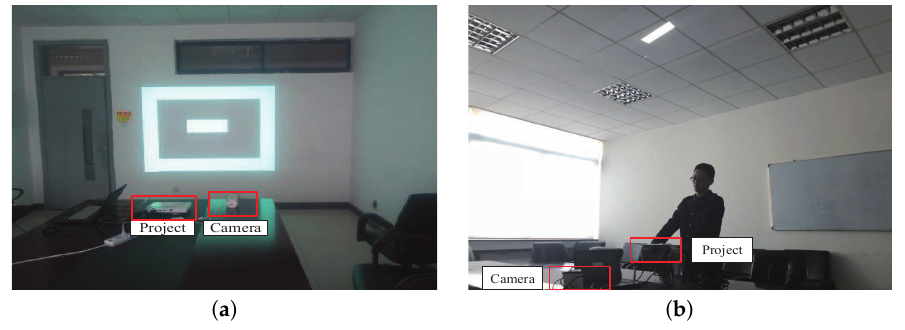
Figure 5. Analog base station. ( a ) static way; ( b ) dynamic way.